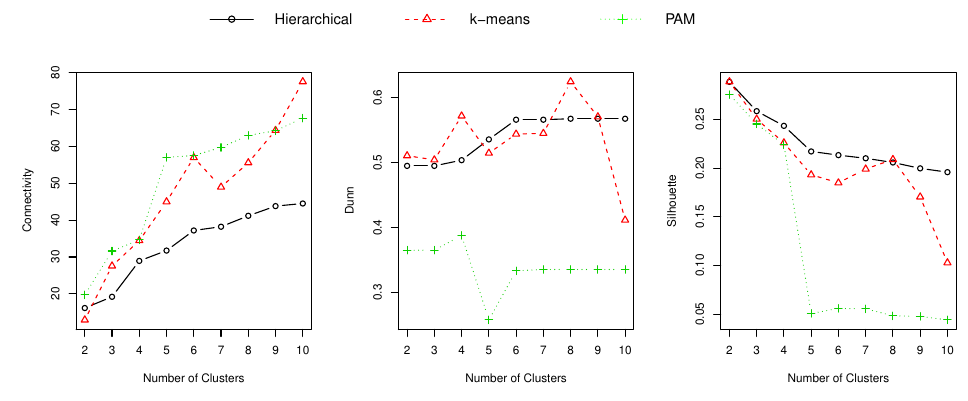
Figure 5. Internal cluster validation for customer segmentation based on the demand signature.